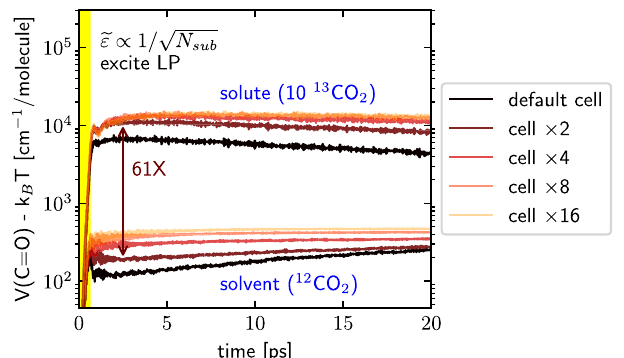
Fig. 5 Effects of the molecular system size on the dynamics of the C = O bond potential energy at constant solute molecular number. This plot is the same as Fig. 4 except for that the 13 CO 2 solute molecular number is fi xed as 10 when the system size enlarges. Note that, when the system size is increased (or when the solute concentration is decreased), both the solvent and solute molecules are more heavily pumped under the same IR excitation of the LP. See text for details of this counter-intuitive